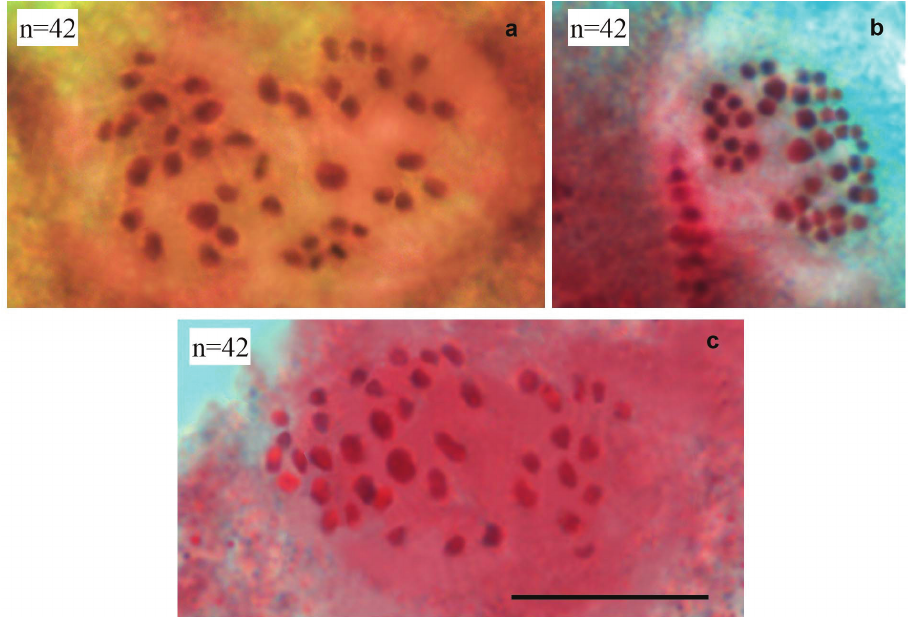
Figure 4. Karyotypes of Polyommatus orphicus from Albania a sample K75, MI, n=42 b sample K76, MII, n=42 c sample K80, MI, n=42. Scale bar: 10